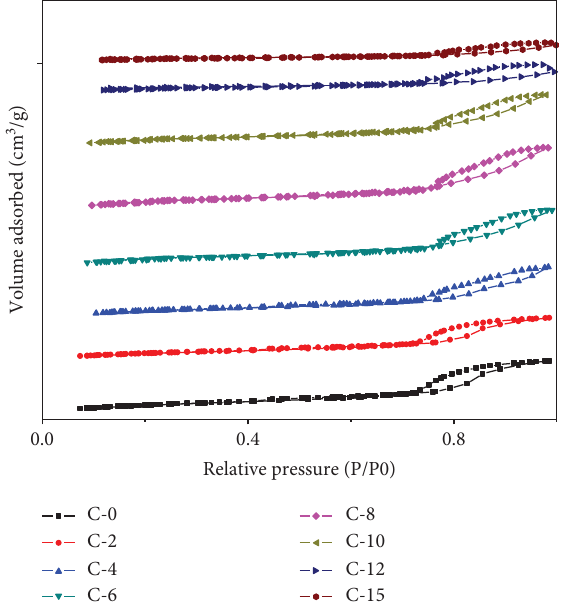
Figure 3: N 2 adsorption-desorption isotherm of